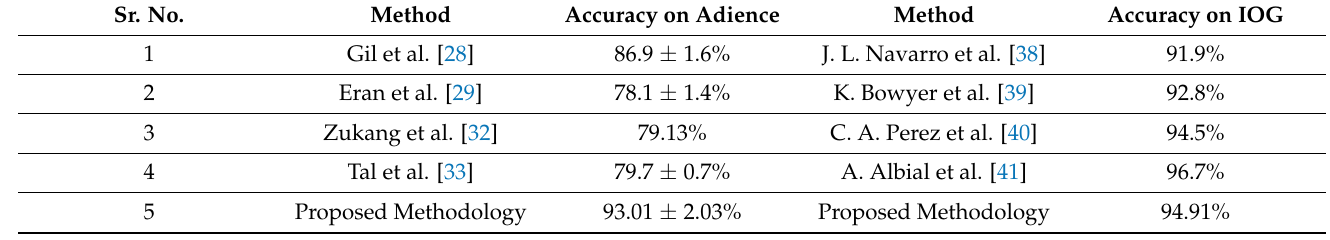
Table 7. Accuracy Comparison for Gender Classification on Adienceand IOG.